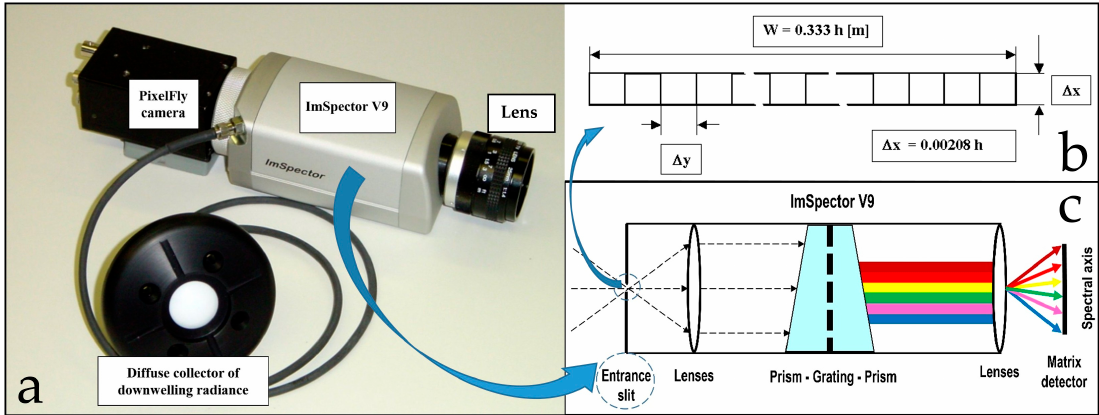
Figure 1. ( a ) ImSpector V9 hyperspectral line scanner with diffuse collector to measure incident down-welling irradiance (connected to the V9 head via fiber-optic cable) and PixelFly matrix camera. ( b ) ImSpector V9 sensor geometry mapping scheme. ( c ) Operating principle of ImSpector V9.